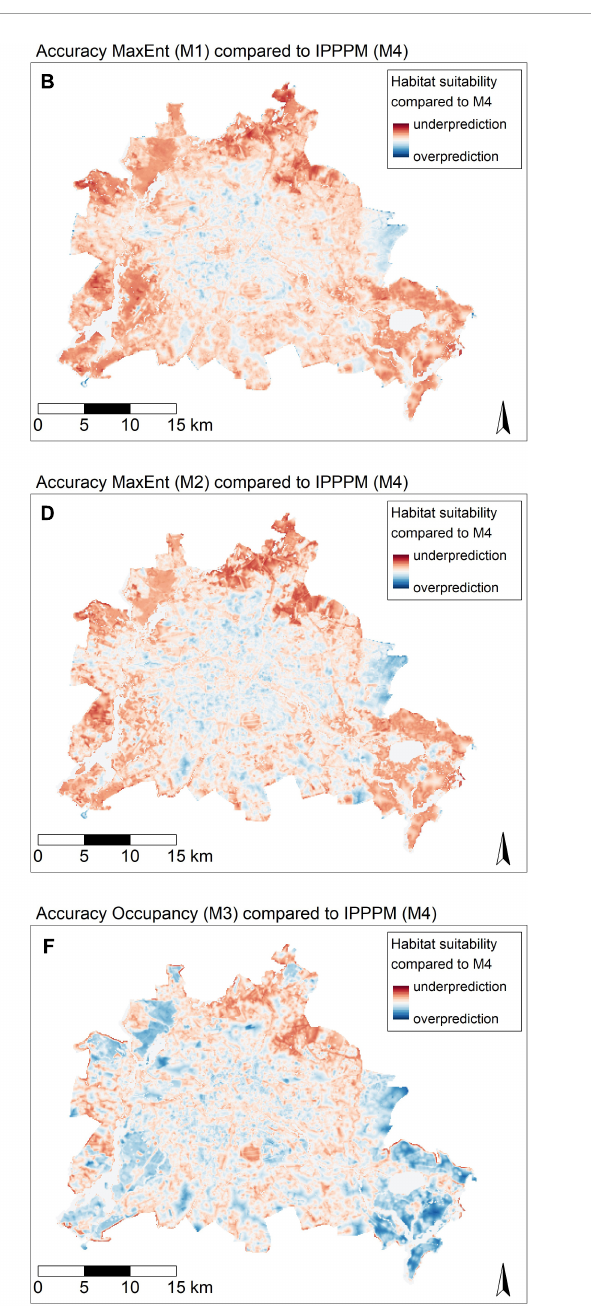
indicating the same set of covariates as the reference model to be important for the species distribution. The same global model was also selected in the coarser resolution of 500 m, and had an increased support compared to all other models.